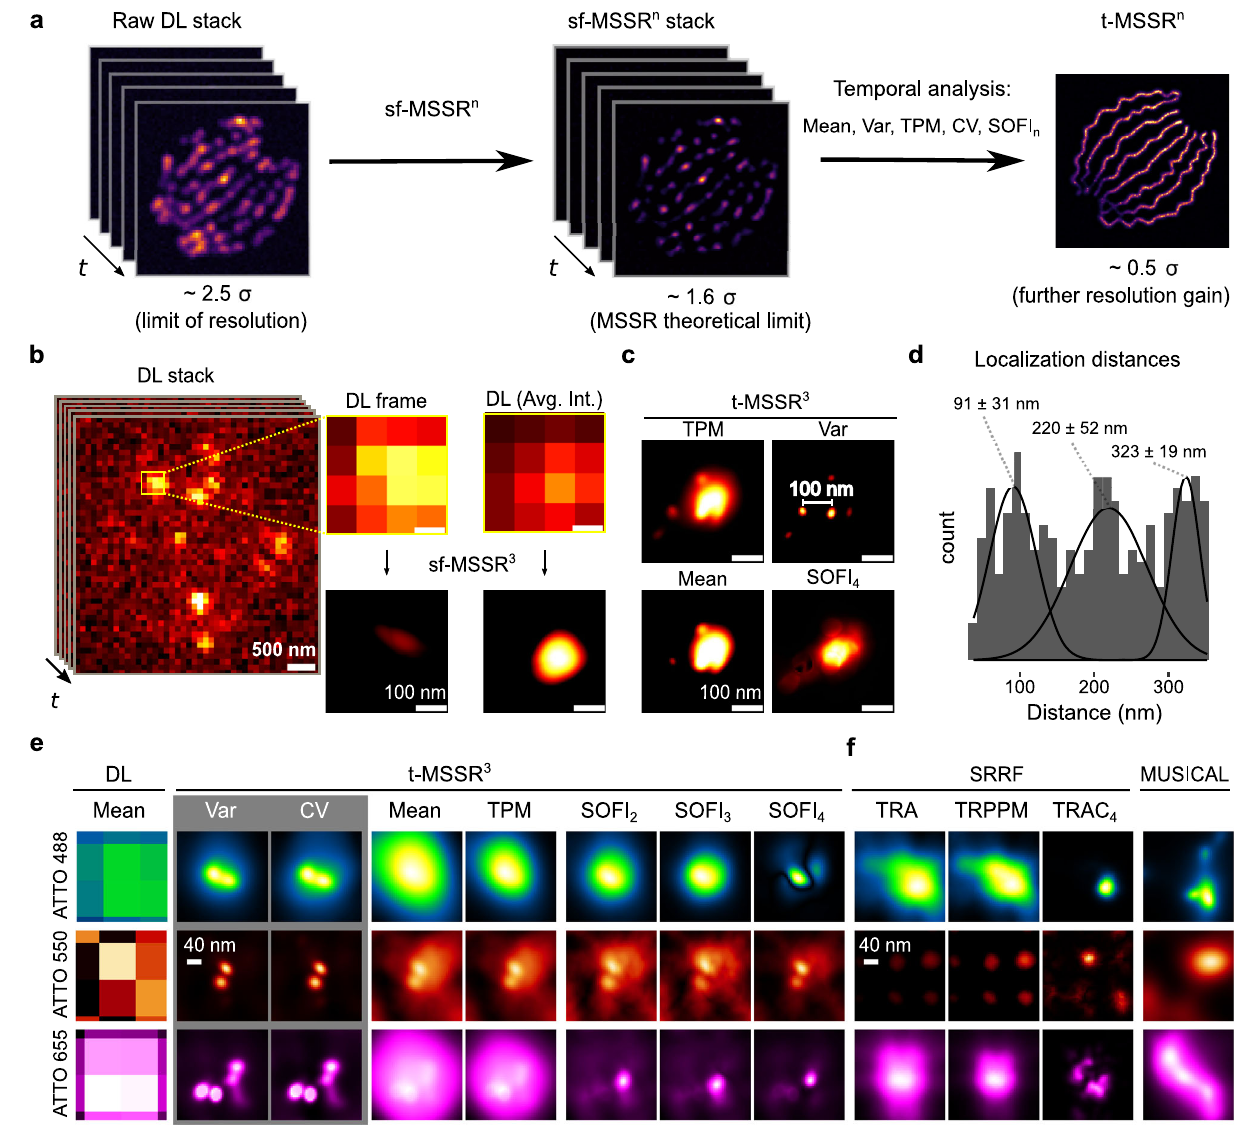
Fig.7|ThetemporalanalysisofMSSRprovidesafurtherincreaseinresolution to 40nm. a Single-frame analysis of MSSR of a given order n is applied to each frame of a sequence, becoming the sf-MSSR n stack. Next, a pixel-wise temporal function(PTF)convertstheMSSRstackintoasinglesuper-resolvedt-MSSR n image. b Left: a stack of DL images of a CRISPR/dCas12a nanoruler system. Right: zoomed regionofthe fi rstframeinthestack,alongwiththeaverageprojection(DL-AVG)of astackof100images,beforeandafterMSSRprocessing. c PTFappliedtoastackof MSSR 3 images (t-MSSR 3 ). Fluorescent emitters are separated by 100nm, as estab- lishedbytheCRISPR/dCas12ananorulersystem.FourtypesofPTFwerecomputed: TPM, Var, Mean and SOFI 4 . MSSR parameters: AMP=20, FWHM of PSF=3.74, order=3, number of images for PTF = 300. pixel size of the DL dataset=100nm. d Euclidean distances between nearby emitters automatically computed from t-MSSR 3